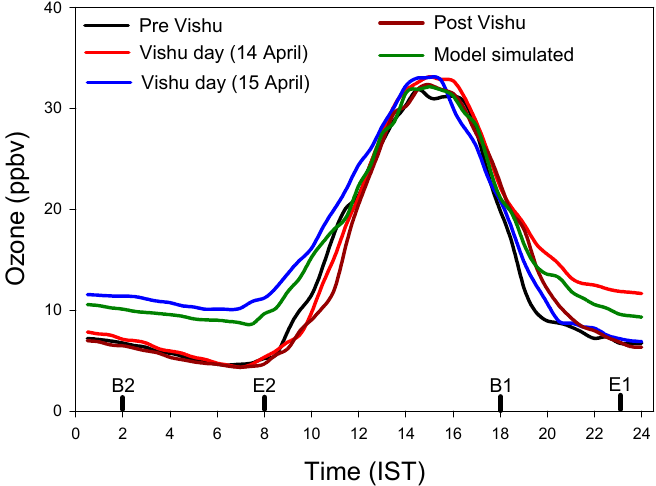
Figure 12. Observed and model simulated O 3 variation during pre-, post-, and Vishu day for the year 2018.